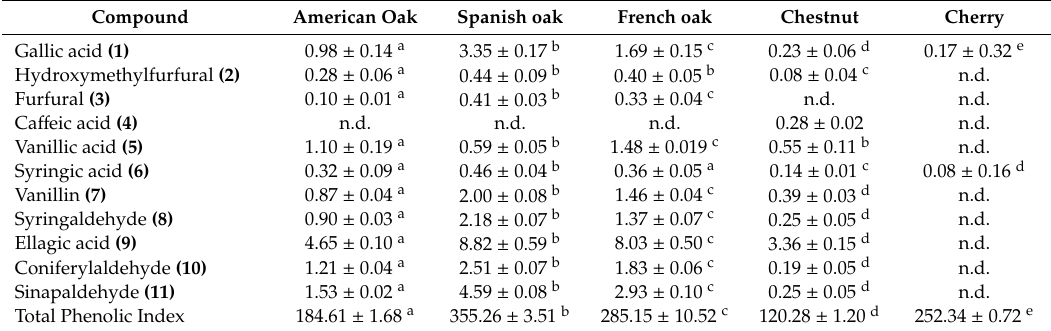
Table 9. Phenolic compounds contents (mg L − 1 ) and total polyphenol index (TPI) (mg gallic acid equivalent (GAE) L − 1 ) of wood